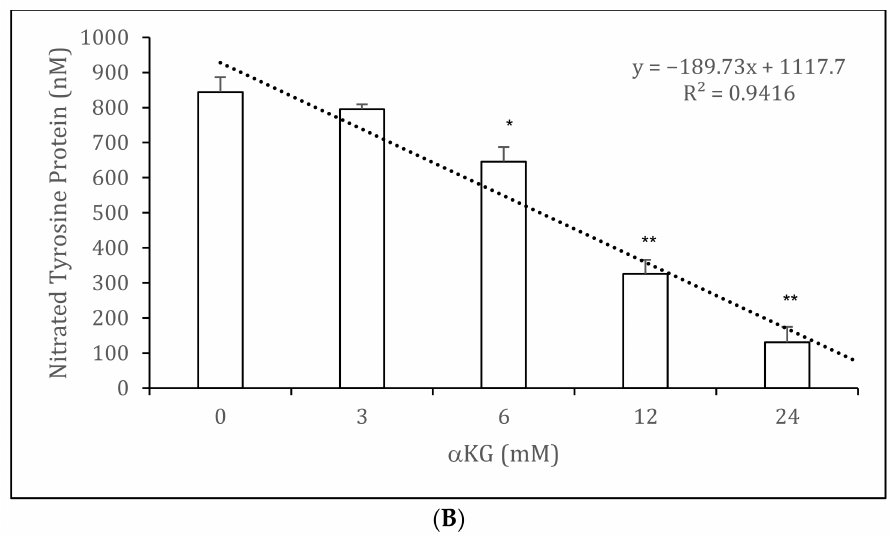
Figure 4. ELISA measurements of tyrosine residues on bovine serum albumin nitrated by ONOO − . ( A ) Standard curve of nitrated tyrosine protein ( n = 5); ( B ) Estimation of nitro-tyrosine residues on bovine serum albumin in the absence or presence of 0 (control), 3, 6, 12, and 24 mM α KG ( n = 5). The relation and its regression term between nitrated tyrosine proteins and α KG concentrations were calculated. * p < 0.01: significant compared to the control; ** p < 0.001: highly significant compared to the